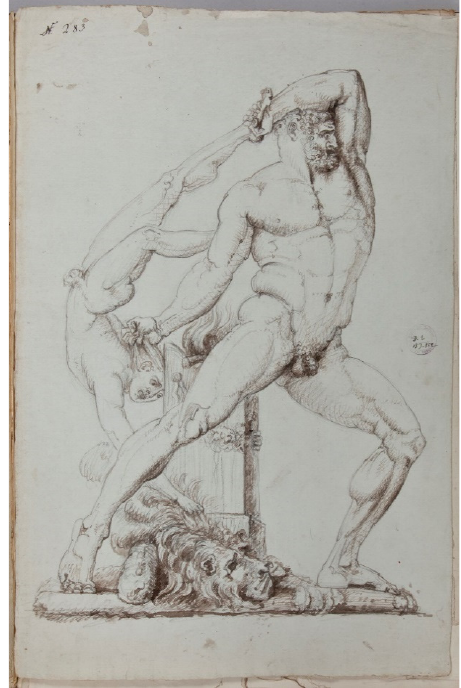
Figure 12. Antonio Canova. Hercules Hurling Lichas into the Sea (sketch), 1795. Museo Civico, Bassano del Grappa.